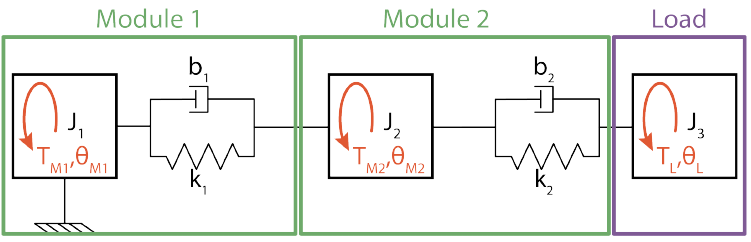
Figure 2. Symplified dynamic model of the drivetrain as a three-inertia